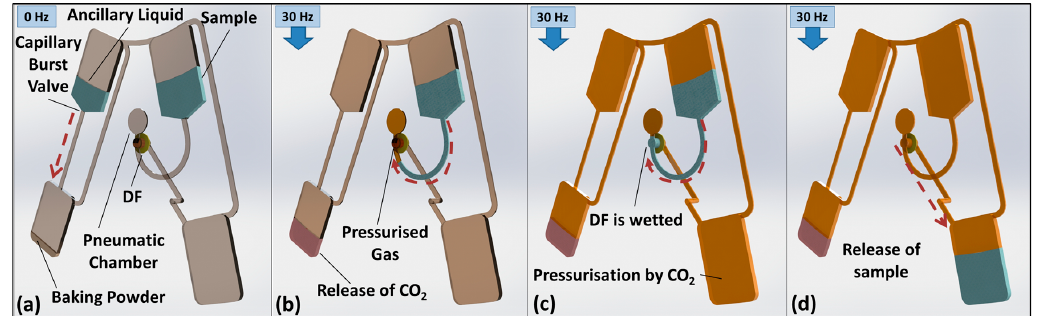
Figure 1. Basic valve operation. Note that the intensity of brown intensity indicates the gas pressure. ( a ) Liquid and baking powder are loaded, and the disc is sealed from the atmosphere using adhesive tape (not shown). In this pneumatically isolated fluidic network, the bypass channels prevent the establishment of uniform pressure. Only the gas pocket at the dissolvable film (DF) membrane is exposed to the hydrostatic pressure head of the upstream sample; ( b ) upon spinning, a capillary burst valve opens and the ancillary liquid reaches the baking powder; the emerging CO 2 gas pressurises the network and thus compresses the gas pocket; ( c ) with increasing production of CO 2 , the sample protrudes into the pneumatic chamber and eventually wets the DF; and ( d ) DF dissolves to open the valve and release the sample.